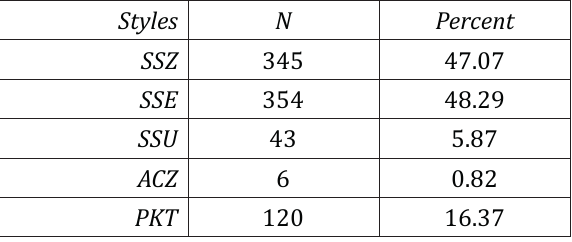
Table 4. The numbers of samples classified in Sten 7 or higher.